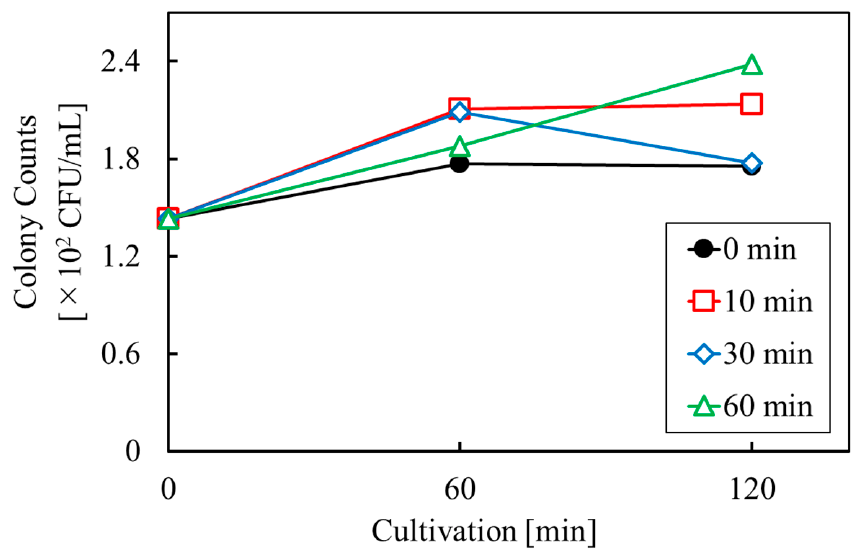
Figure 3. Colony counts versus cultivation time in E. coli suspensions subjected to different bubbling times.